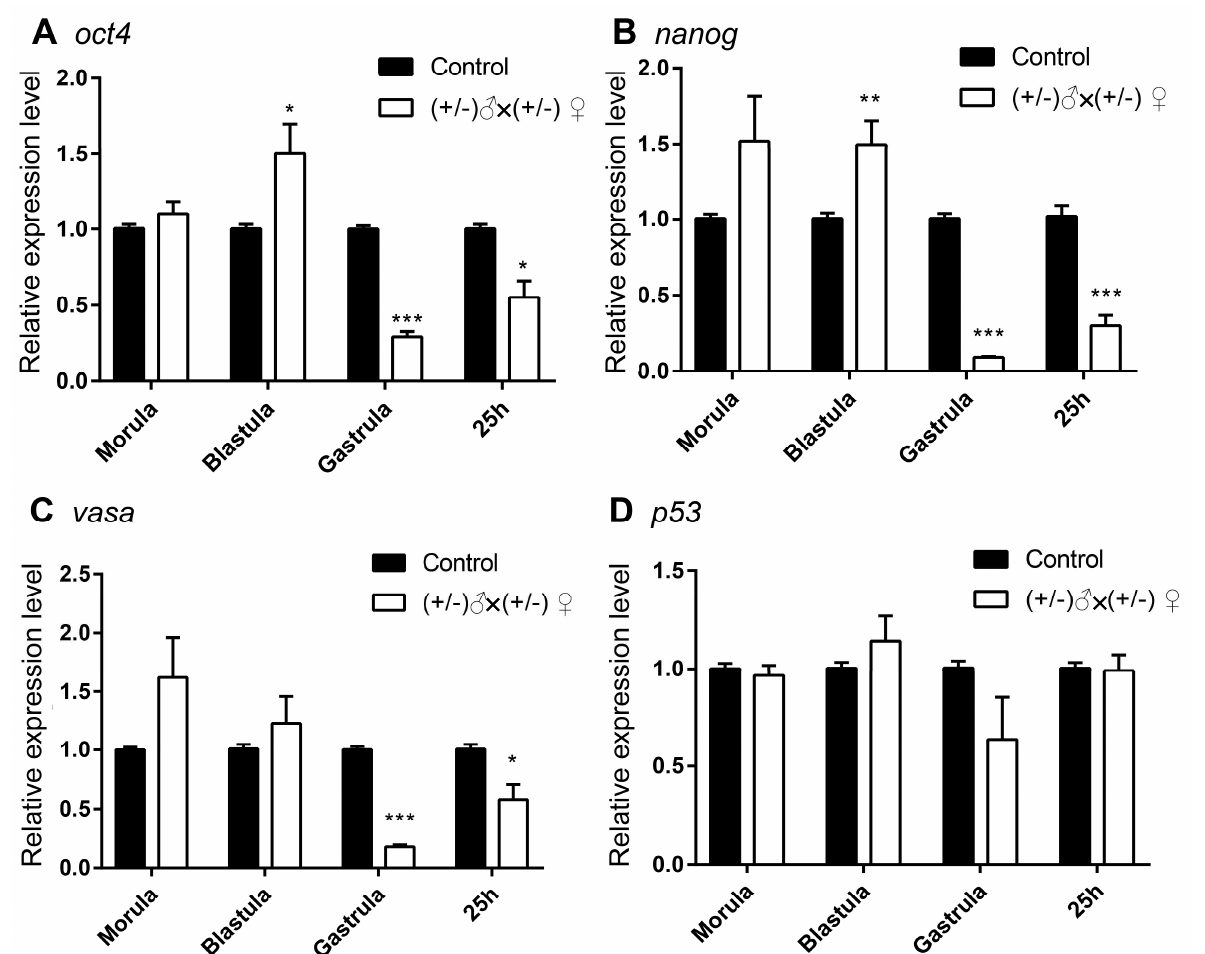
Figure 4. The relative expression of oct4 ( A ), nanog ( B ), vasa ( C ), and p53 ( D ) in the embryos from the morula stage to 25 hpf. The expression of each gene in the control at the same stage was set as 1. The asterisks show the significances. *, p < 0.05; **, p < 0.01; ***, p < 0.001.